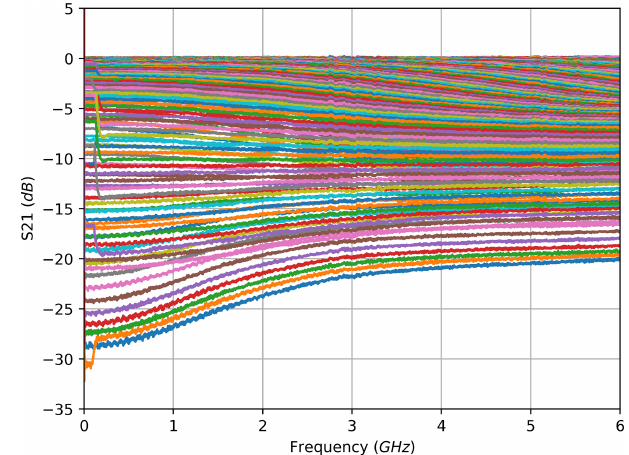
Figure 19. Measured amplitude for cFBG in reflection configura-